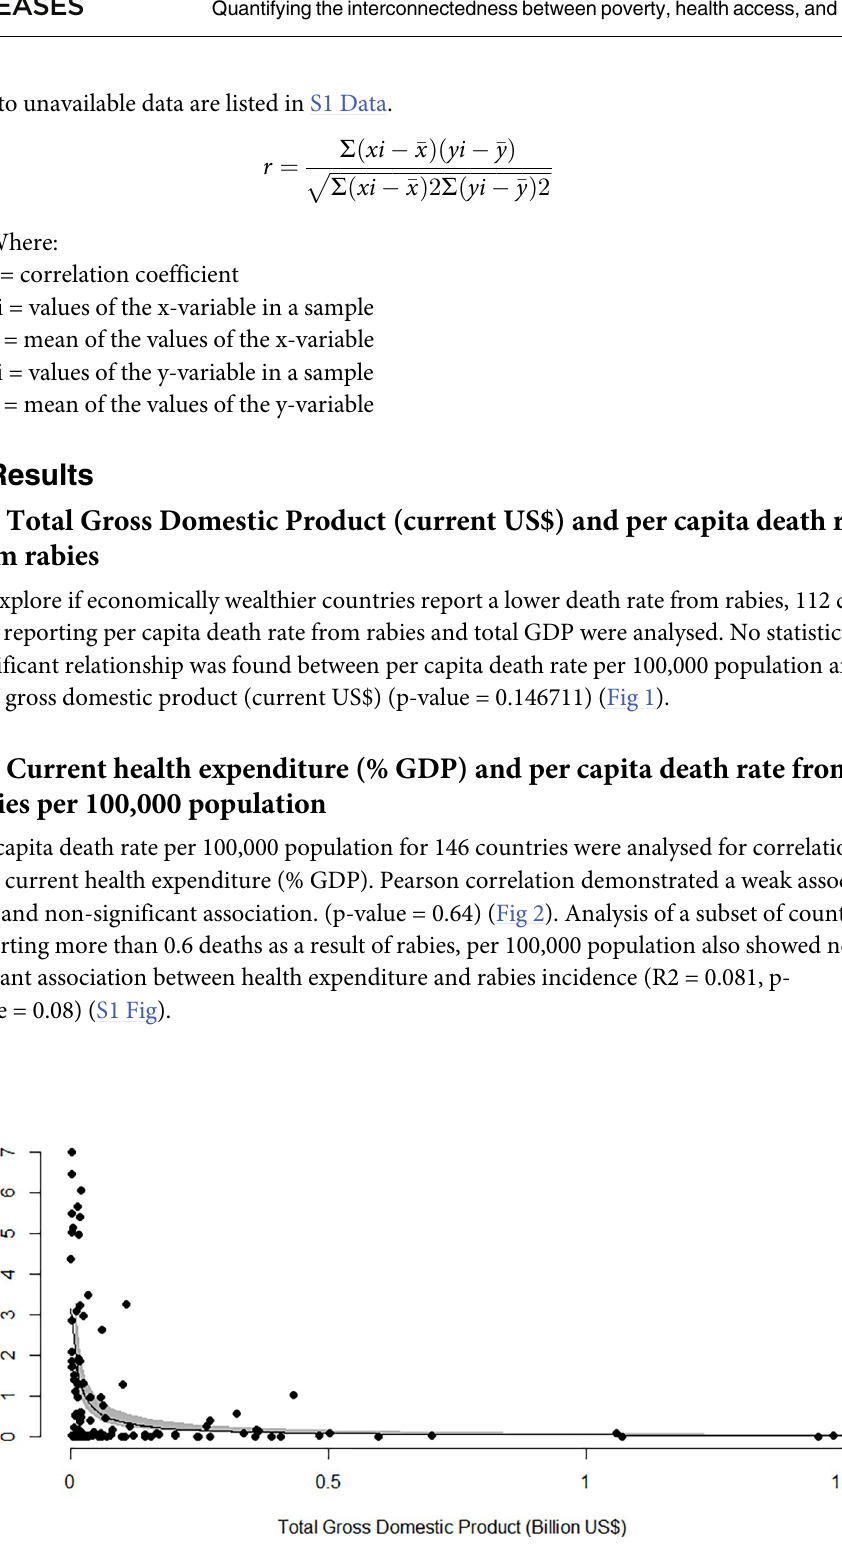
Fig 1. Results from the Generalised Linear Regression Model with Gamma distribution showing the relationship between total Gross Domestic Product (current US$) from 2020, and per capita death rate from rabies per 100,000 population from 2015, for 112 countries where data were available. (Minus outliers Myanmar, India, China, Turkey).